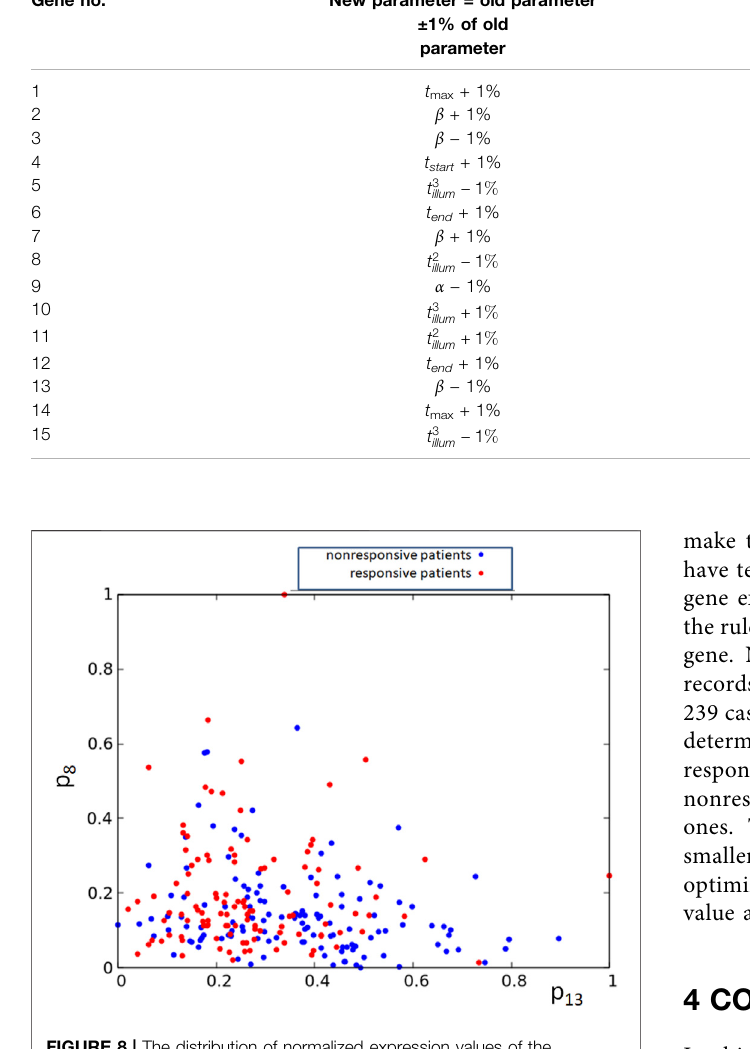
Frontiers in Chemistry |